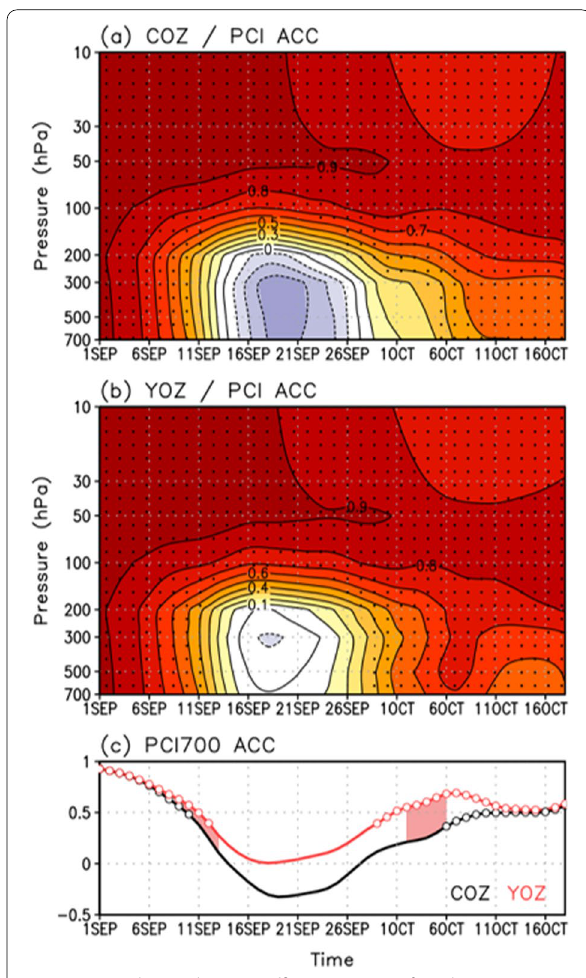
Fig. 2 Anomaly correlation coefficients (ACCs) of 14‑day running averaged PCI as a function of forecast lead time in a COZ and b YOZ experiments for the period of 2004–2020. The values which are statistically significant at the 95% confidence level are dotted. c ACCs of 700‑hPa PCI in COZ experiment in black and those in YOZ experiment in red. Open circles denote the values which are statistically significant at the 95% confidence level. The forecast time when the ACC difference (YOZ minus COZ) is statistically significant at the 95% confidence level is shaded in pink. Note that October 6 in x ‑axis refers to the ACC at the forecast week